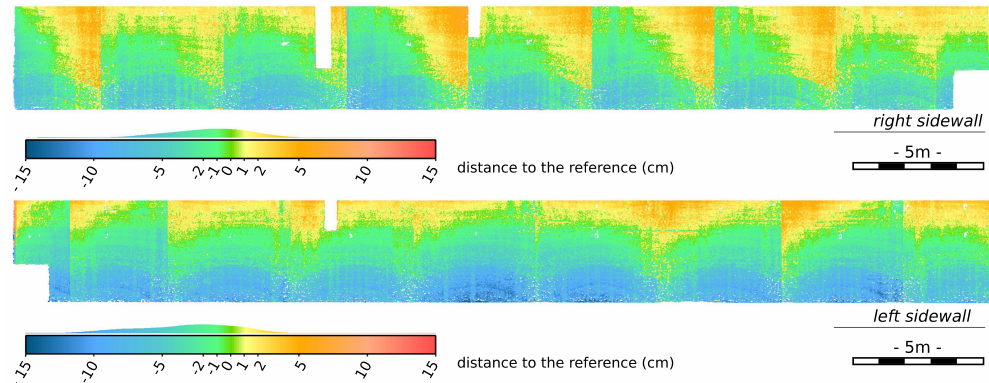
Figure 15. Distribution of distances between the sonar point cloud and the mesh constructed from TLS data, before tilt angle correction (top) for the right wall and (bottom) for the left wall.